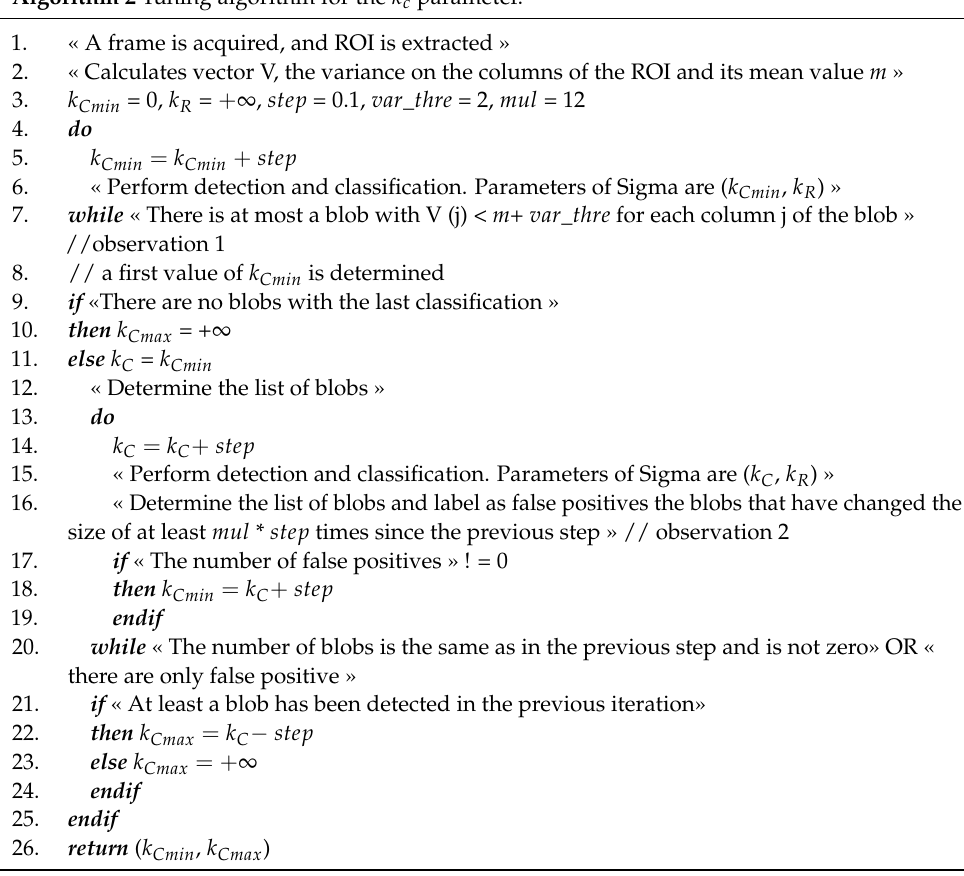
Algorithm 2 Tuning algorithm for the k c parameter.